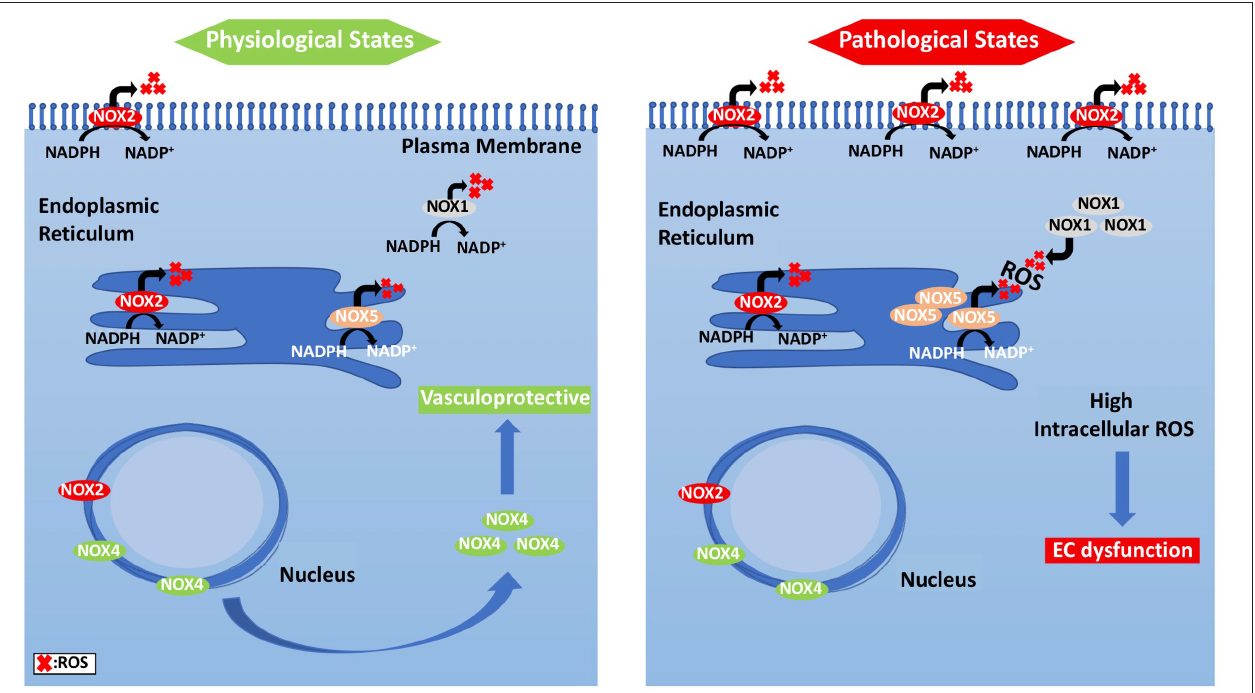
FIGURE 4 | Subcellular localization of NADPH oxidases and compartmentalization of NOX2-derived ROS and their effects on EC signaling pathways. (Left panel) ECs under physiological states, where NOX2 expression is low and NOX4 levels are increased, show vasculo-protective phenotype. (Right panel) Under pathological states, however, NOX2 forms clusters, and is responsible for ROS generation.